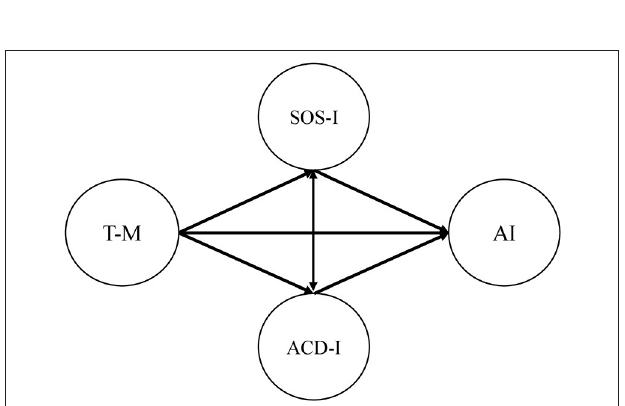
FIGURE 2 | Conceptual model. T-M, Time-management skills; SOS-I, Social integration; ACD-I, Academic integration; AI, Attrition Intentions (Drop-out, Transfer University, Transfer Study